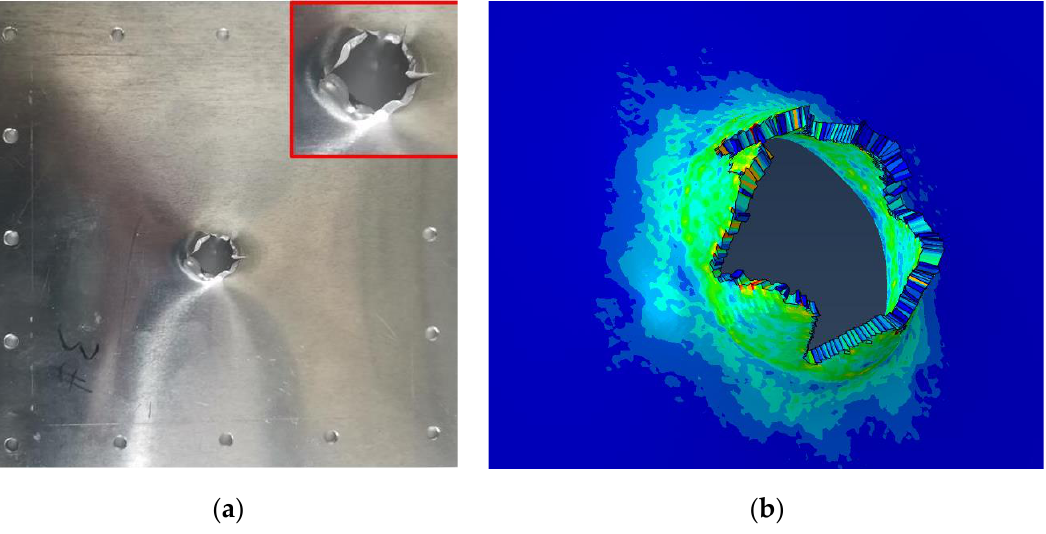
Figure 12. Simulation and experiment comparison: ( a ) experiment results; ( b ) simulation results.